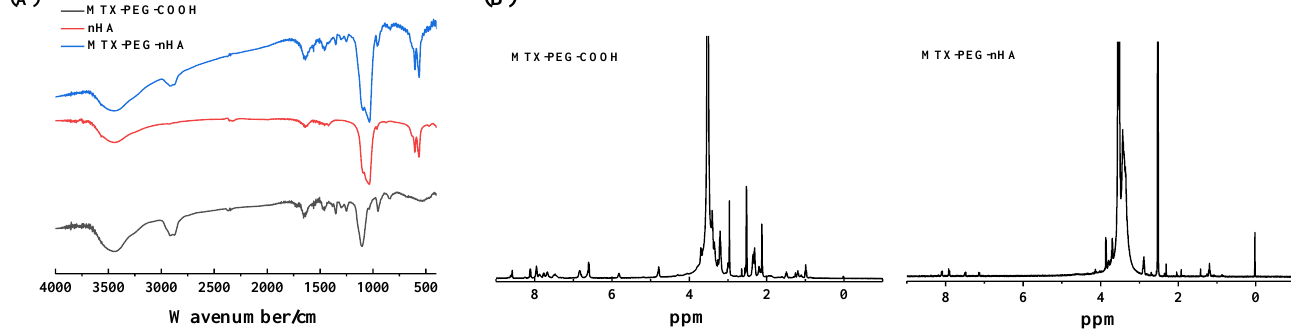
Figure 1. ( A ) FTIR spectra of nHA, MTX-PEG-COOH and MTX-PEG-nHA. ( B ) 1 H NMR spectra of MTX-PEG-COOH and NH 2 -PEG-COOH.